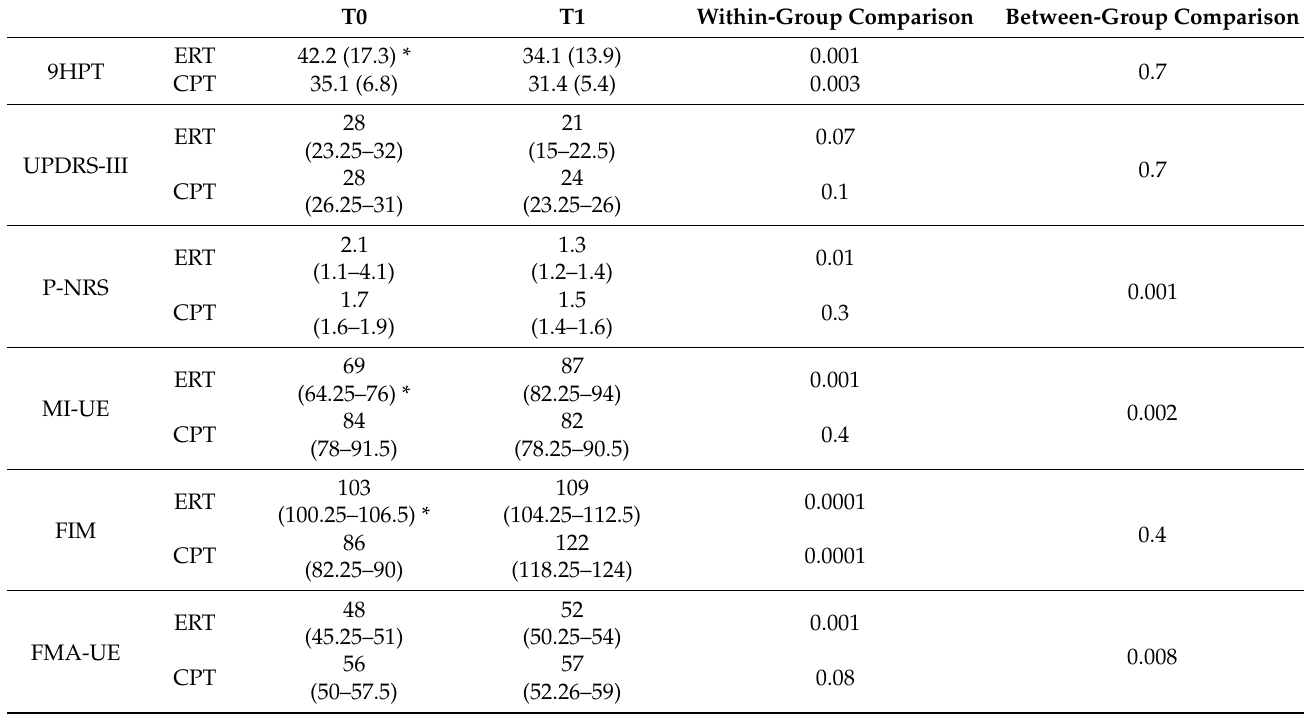
Table 3. Affected side assessment at T0 (baseline) and T1 (post-treatment) in the ERT ( n = 15; * n = 12) and CPT ( n = 9) group. Data are reported as mean (SD) or median (interquartile range), and p -value of within-group (using t -test or Wilcoxon test) and between-group comparison (using t -test or Mann–Whitney